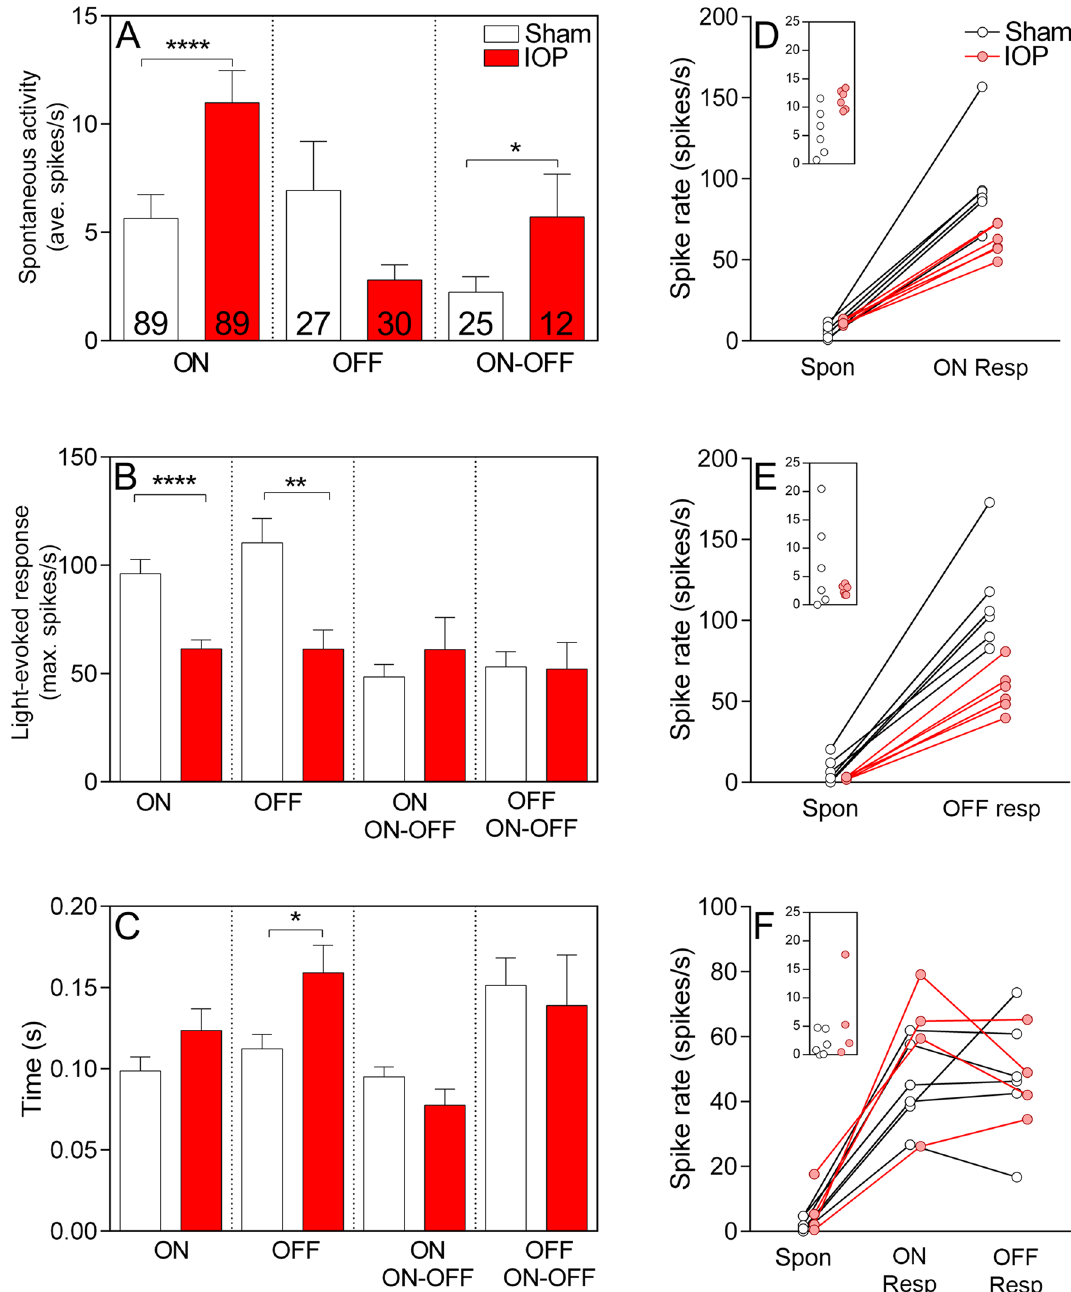
Figure 5. pMEA recordings of P2X7-KO mice demonstrate dysfunction of OFF-RGCs, without rescue, and additional dysfunction of ON-RGC following acute IOP elevation. ( A ) Spontaneous activity was increased in ON and ON–OFF RGCs and ( B ) light-elicited responses were reduced in ON- and OFF-RGCs following elevated IOP (red bars). ( C ) The latency to peak response was increased in OFF-RGCs following elevated IOP. Numbers indicate the number of cells recorded from n = 6 animals. ( D – F ) The spontaneous activity and light- elicited responses were averaged per retina and are presented per retina for ON- ( D ), OFF- ( E ) and ON–OFF ( F ) RGCs. Insets show the spontaneous rate of cells from sham and elevated IOP eyes. Both ON- and OFF- RGCs from the P2X7-KO mouse showed reduced light responsiveness following acute IOP elevation* p < 0.05, ** p < 0.01, **** p < 0.0001; Mann–Whitney test (sham vs